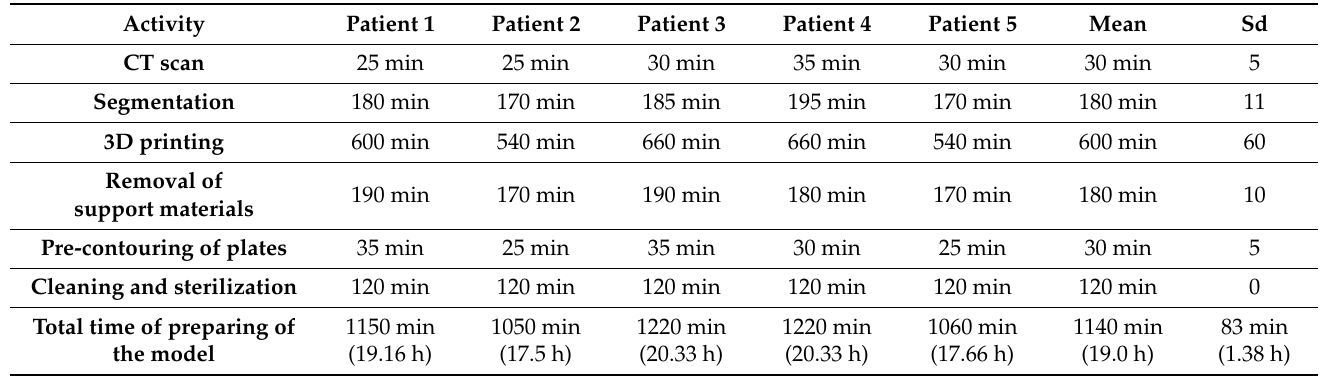
Table 4. Time required to carry out each step in the Fast Track protocol (mins—minutes, h—hours, sd—standard deviation).